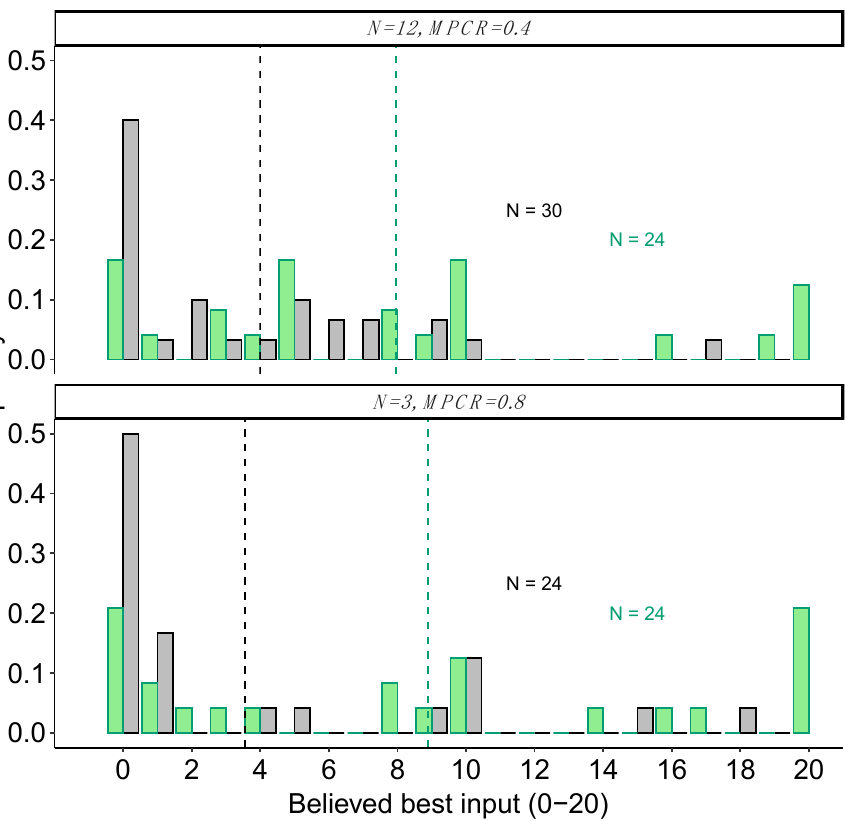
Figure 5. Game length and beliefs. Histograms show the frequency of each stated belief about what was the best number to input into the black box. Dashed vertical lines show the mean response. Beliefs were more accurate after a longer game. All responses are from naïve participants after finishing their first black box. The figures are annotated with the number of individuals.